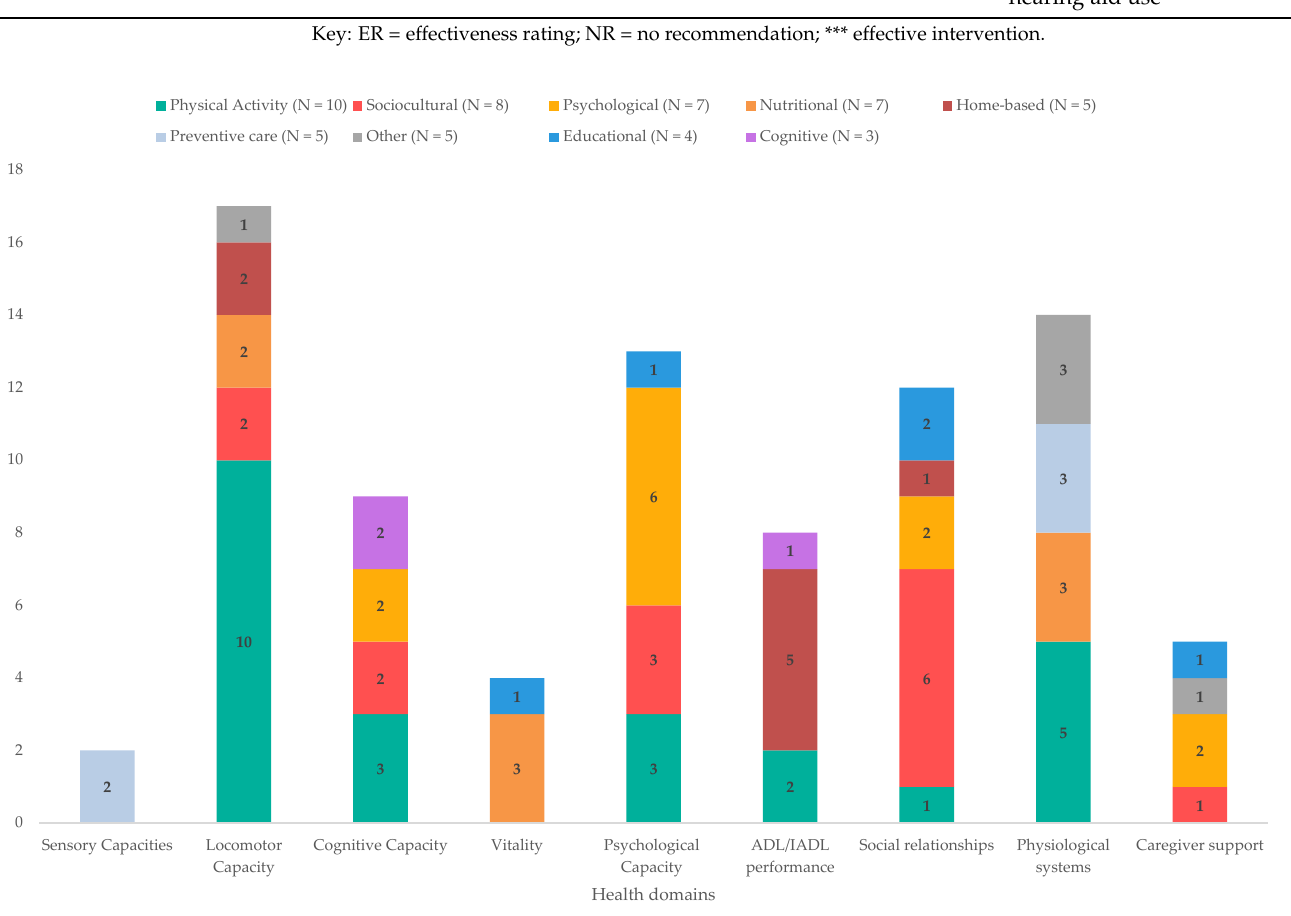
Figure 2. Summary of the types of interventions identified, and the breakdown of the domains they